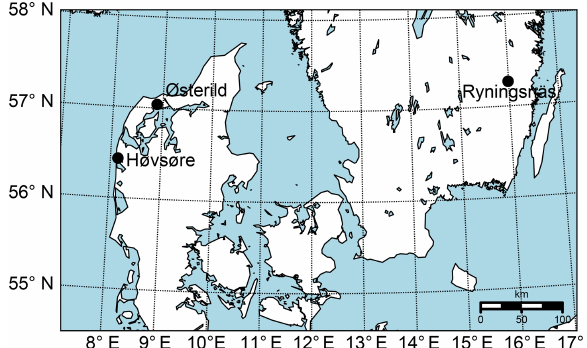
Figure 1. A map of Denmark and southern Sweden showing the locations of the measurement